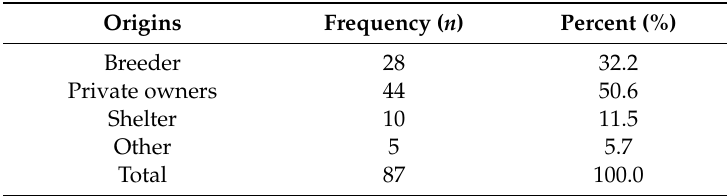
Table 10. Origins of dogs aggressive towards